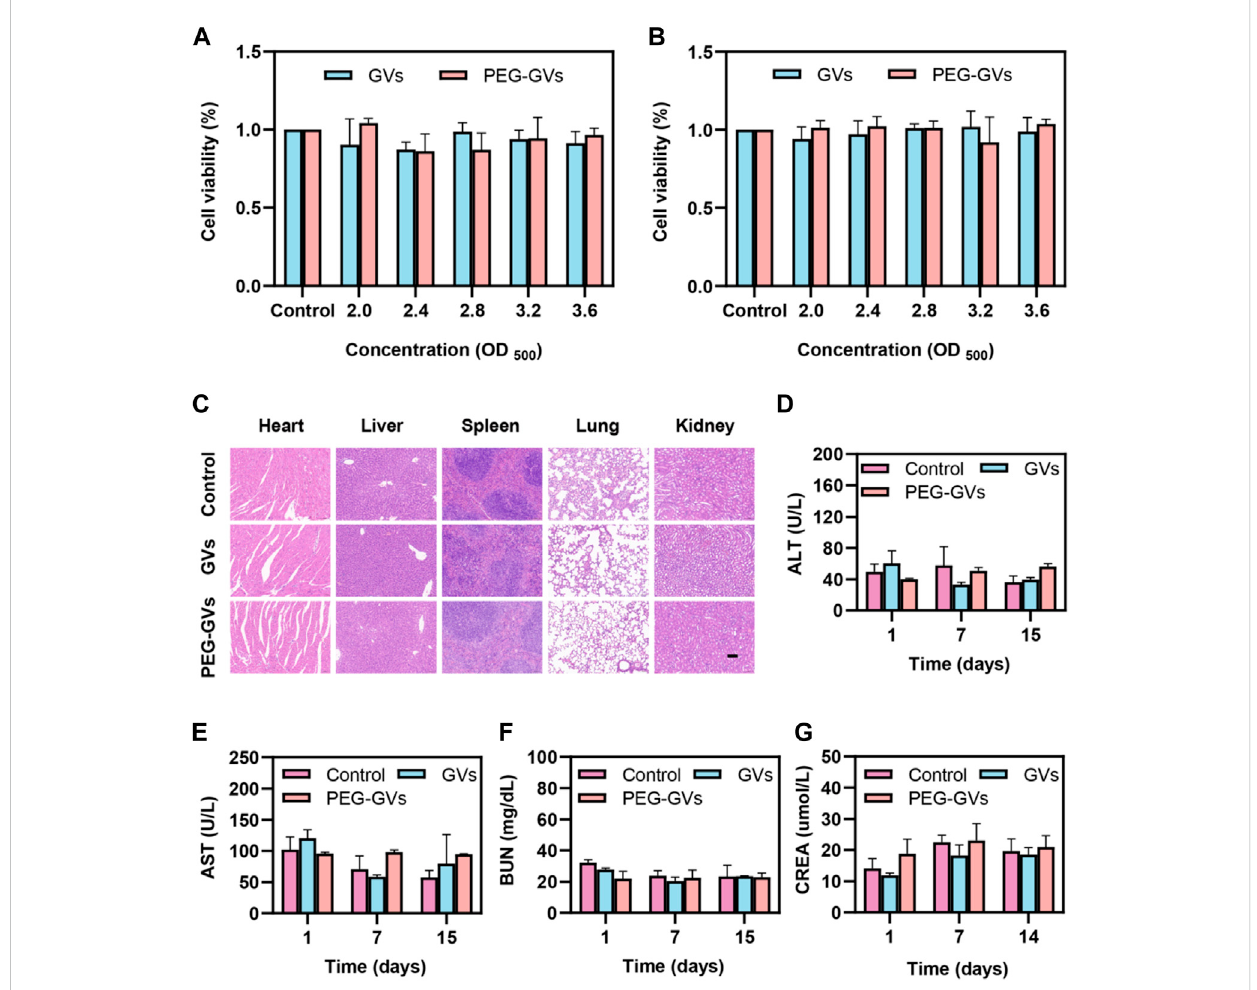
500 =0,2.0,2.4,2.8,3.2,and3.6)for24h; (C) H&Esectionsofthevitalorgans(heart,liver,spleen,lung,andkidney)afterGVs or PEG-GVs treatment for 16 days (Scale bars = 100 μ m). Changes in blood biochemical indicators of liver and kidney function in the control group,